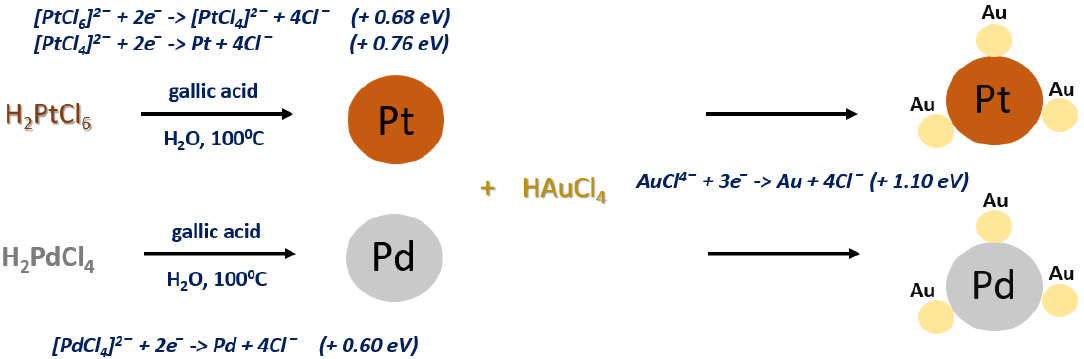
Figure 2. Proposed scheme of the PtAu and PdAu NPs synthesis.